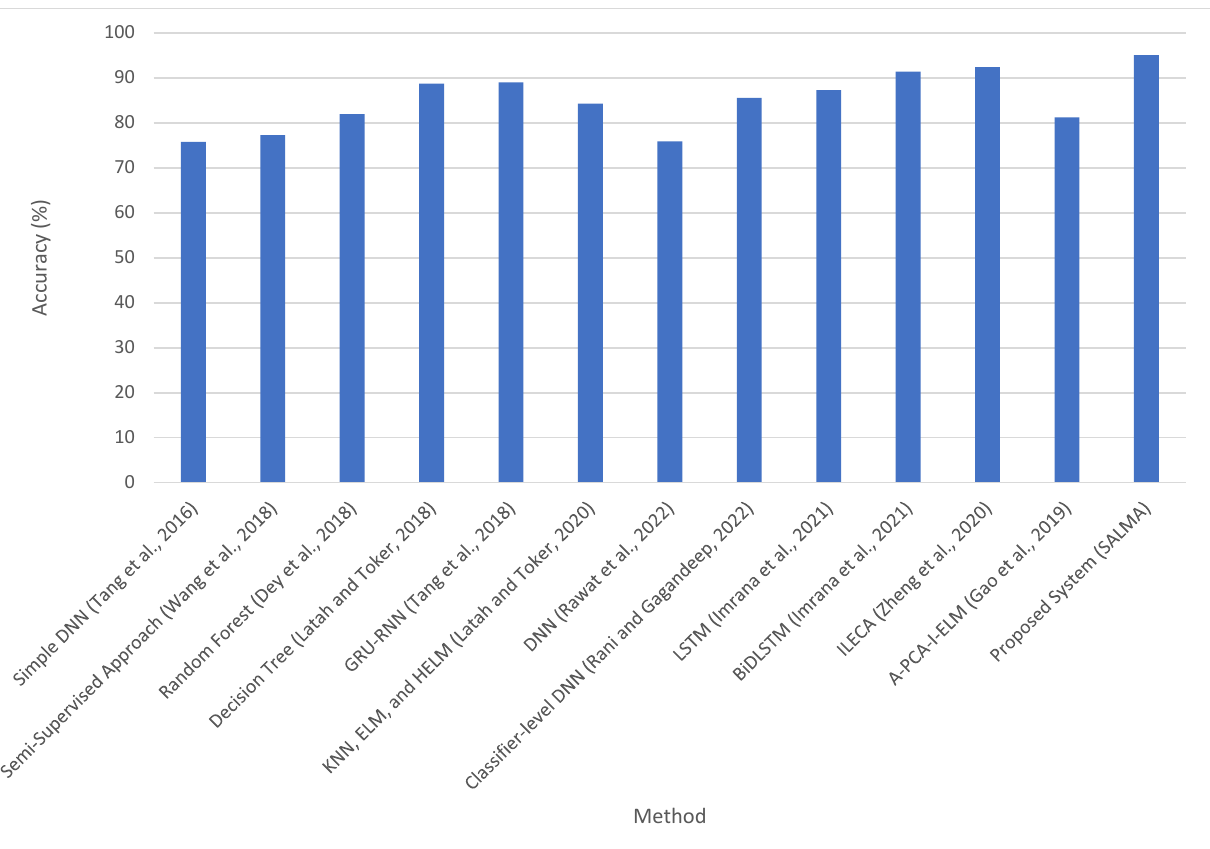
Figure 11. Accuracy comparison between the proposed system and previous approaches on the NSL-KDD dataset [5,13 – 20,22,23].